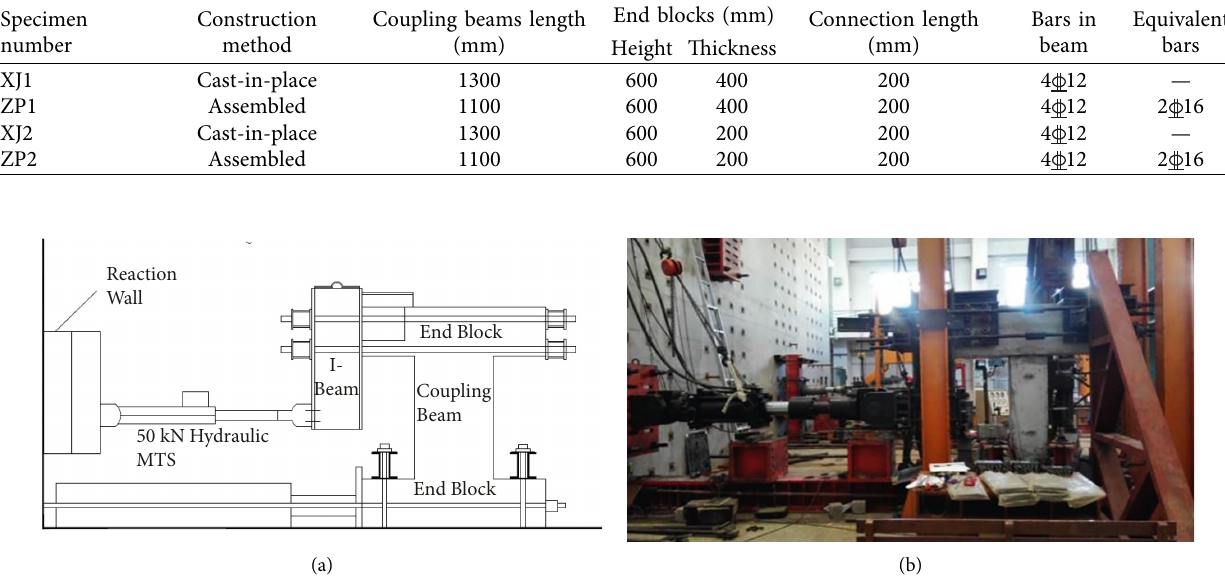
Figure 3: Loading device diagram. (a) Design test loading device diagram. (b) Actual loading device